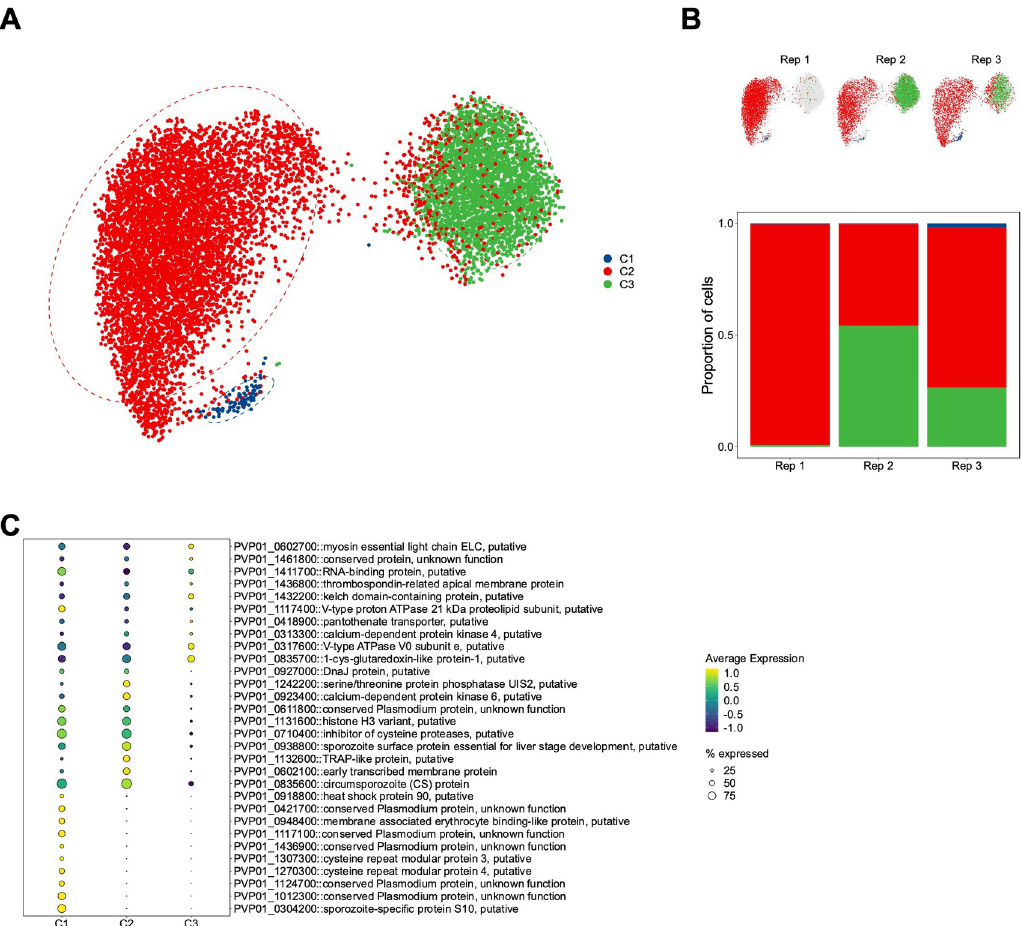
Fig 3. Clustering and differential gene expression analysis of P . vivax sporozoites. (A) UMAP of integrated P . vivax sporozoite transcriptomes coloured by cluster (Leiden algorithm; resolution parameter = 0.1). (B) UMAP of integrated P . vivax sporozoite transcriptomes split by replicate (upper) and the percentage of sporozoites in each cluster from the replicate (lower). (C) Dot plot showing top markers that distinguish each of the three clusters. The size of the dot corresponds to the percentage of sporozoites expressing the gene. Scale bar: normalised expression,